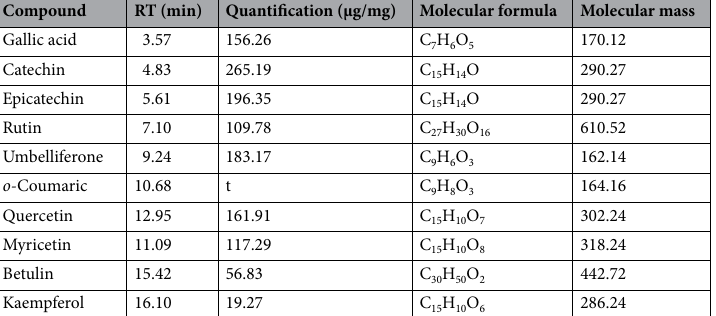
Table 2. HPLC based phenolic fingerprinting and quantification of the major polyphenols in ethyl acetate fraction of crude methanol extract of Acacia nilotica . RT: Retention Time. “t” indicates “trace”.